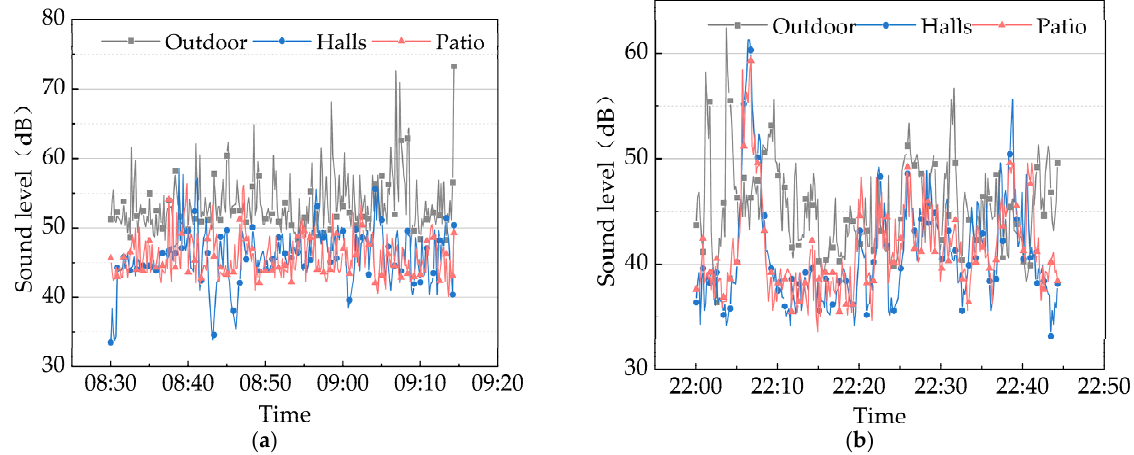
Figure 19. Sound pressure values of the “Yao’s House” at different test points. ( a ) Daytime; and ( b ) nighttime.